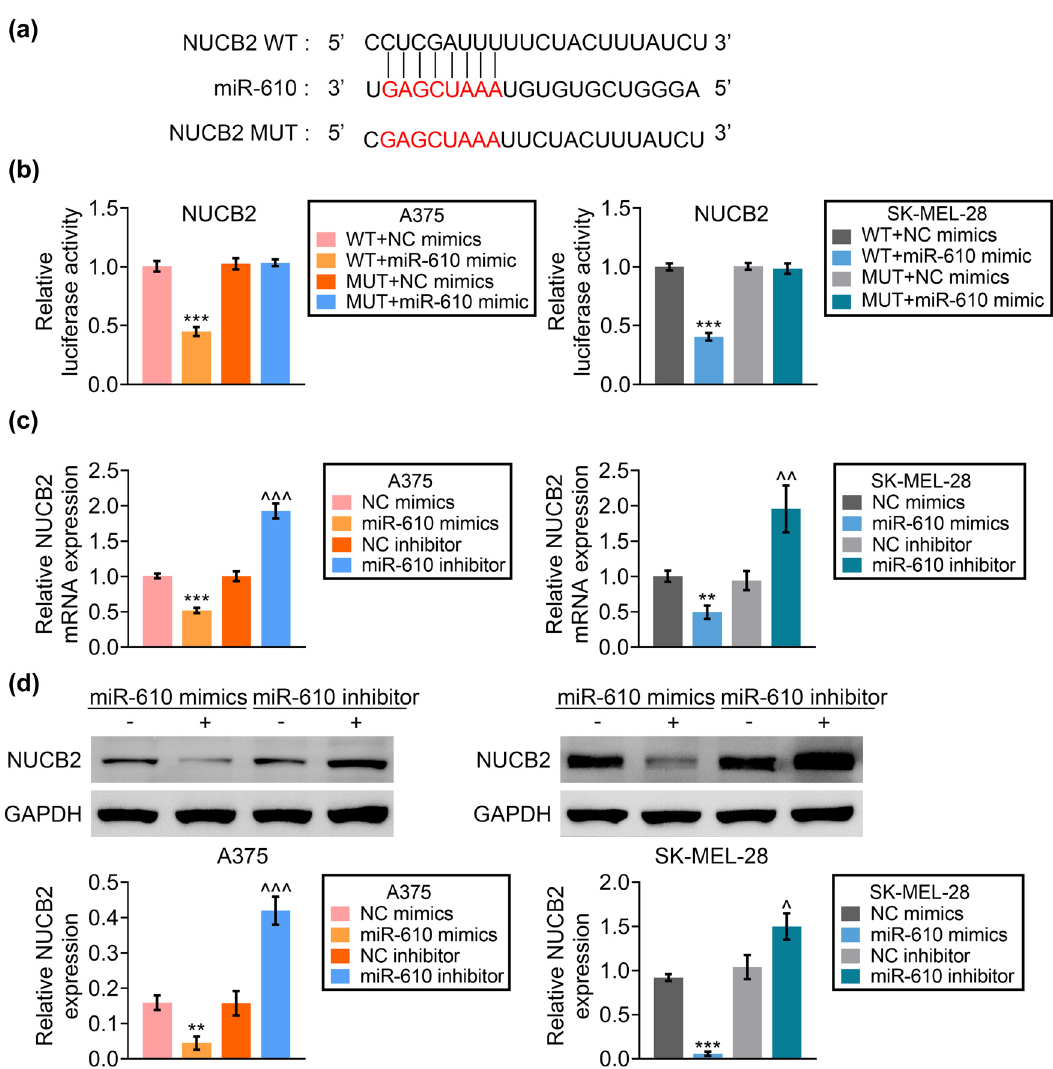
Figure 4: miR - 610 binds to NUCB2. ( a ) Potential binding site between NUCB2 and miR - 610 using miRDB. ( b ) Over - expression of miR - 610 decreased the luciferase activity of pmirGLO - WT - NUCB2 in A375 and SK - MEL - 28. ( c ) Silence of miR - 610 increased mRNA expression of NUCB2, while over - expression of miR - 610 decreased NUCB2 in A375 and SK - MEL - 28. ( d ) Silence of miR - 610 increased protein expression of NUCB2, while over - expression of miR - 610 decreased NUCB2 in A375 and SK - MEL - 28. **, *** vs siNC, p < 0.01, p < 0.001. ^, ^^, ^^^ vs NC, p < 0.05, p < 0.01, p <